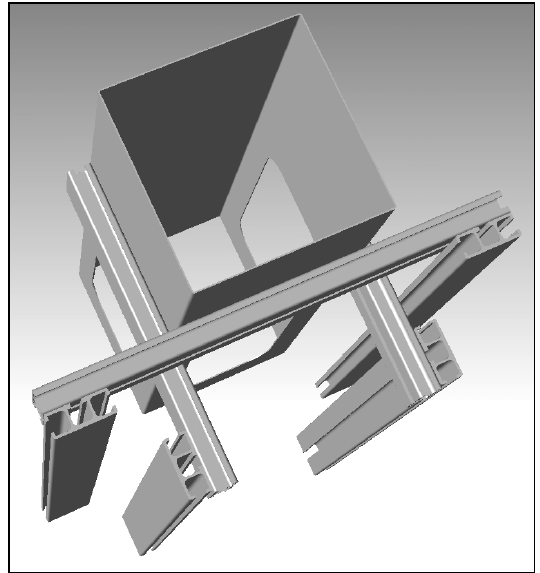
Fig. 23. Rather complicated design of fixating the test section (while the rest of the tunnels is translatable on rails) was necessitated by the request all three large access windows being simultaneously accessible for cameras. The components of the fixation structure are standard aluminium-alloy profile rods, commercially available. Triangular holders as well as the screws are here not